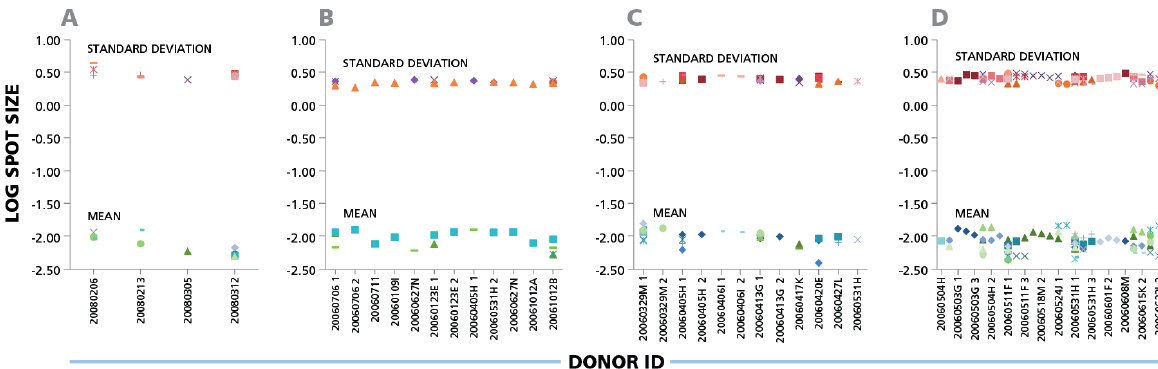
Figure 3. IFN- γ ELISPOTs produced by CD8 cells show a maximal three- to four-fold size variation between donors and antigens. Four independent experiments are shown in panels ( A ), ( B ), ( C ), and ( D ). IFN- γ CD8 responses of different donors against 32 individual CEF peptides are shown as different symbols. For each individual donor/peptide combination 1000 spots were analyzed. The mean spot sizes (mm 2 ) and SD in the logarithmic scale (y- axis) are plotted vs. the PBMC donor’s ID (x-axis).